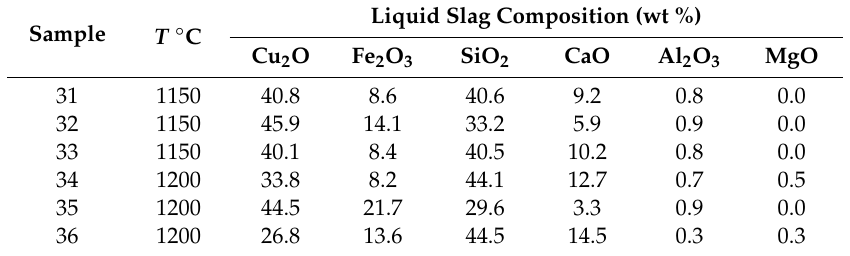
Table 4. Liquid compositions (wt %) of industrial slag samples after equilibration at 1150 ◦ C and 1200 ◦ C.